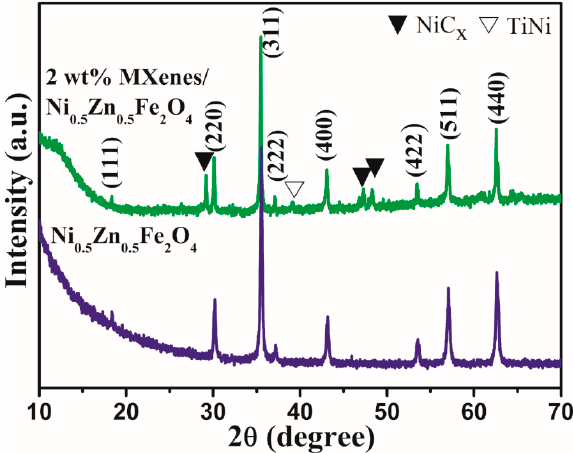
Figure 3. XRD patterns of pure NiZn ferrite and 2 wt.% Ti 3 C 2 T x /NiZn ferrite composites after sintering at 800 ° C by FAST.